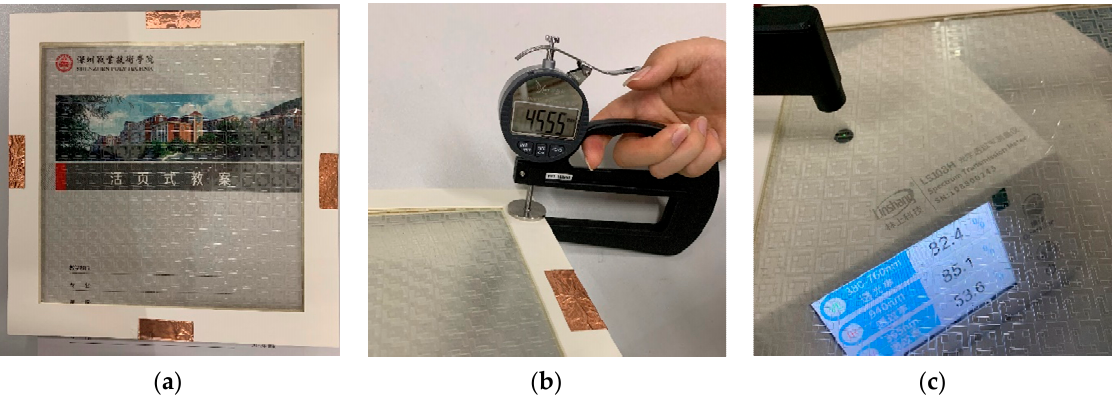
Figure 7. Measurement of thickness and optical transmittance for fabricated sample. ( a ) Fabricated sample. ( b ) Thickness measurement. ( c ) Optical transmittance measurement.